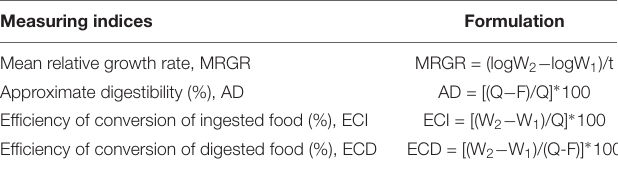
TABLE 1 | Calculations for indices for larval growth, development, and food digestibility. Measuring indices